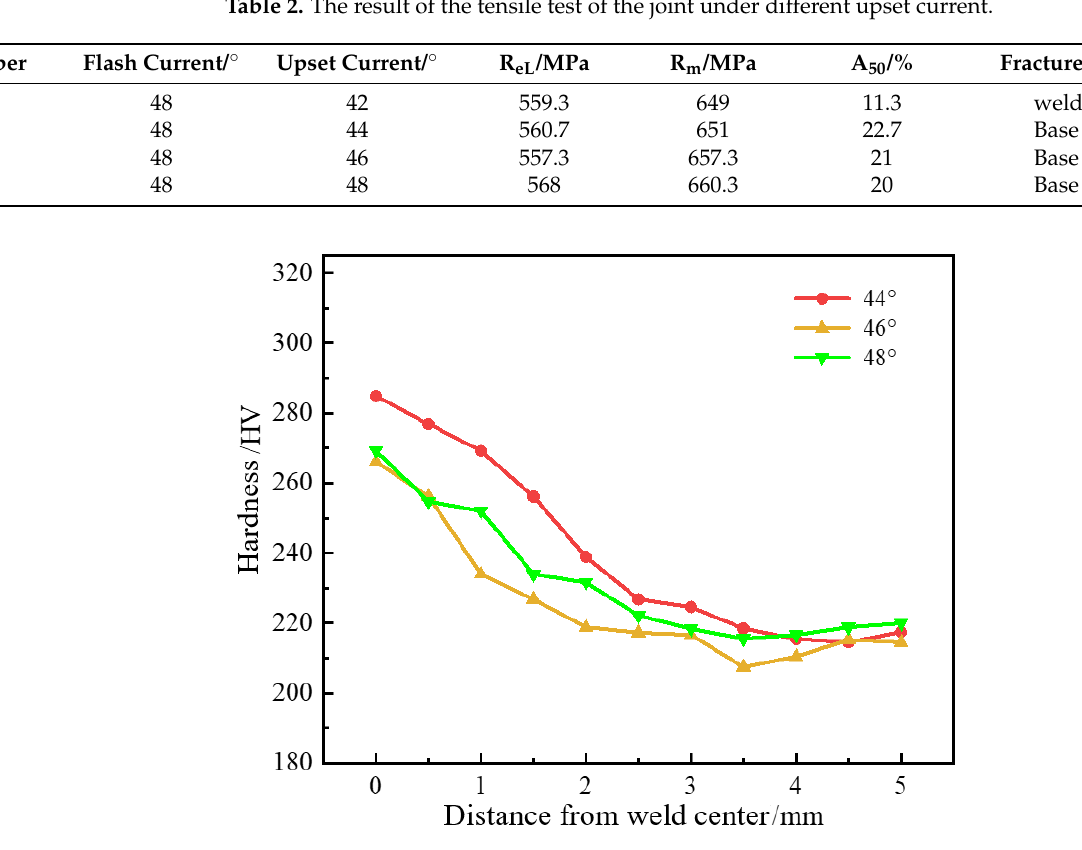
Figure 3. Hardness distribution of the joint under a different upset current.